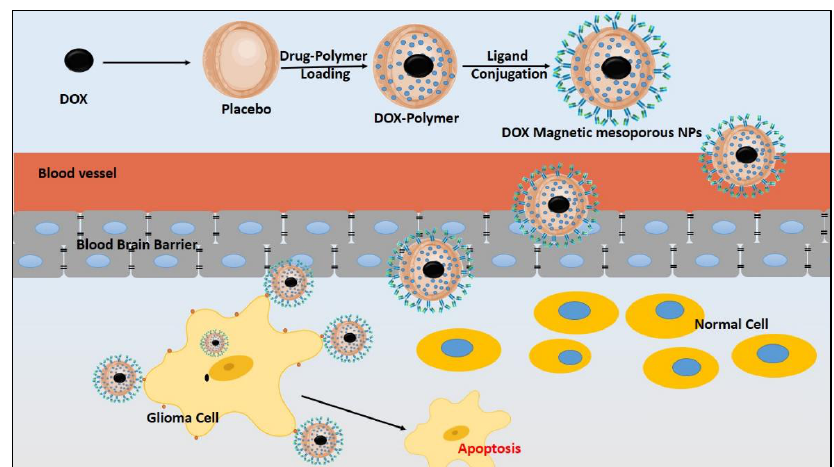
Figure 7. Synthesis of magnetic mesoporous nanoparticles using polymer and subsequently conjugated with ligands to achieve the sustained release of the drug at the specific targeted